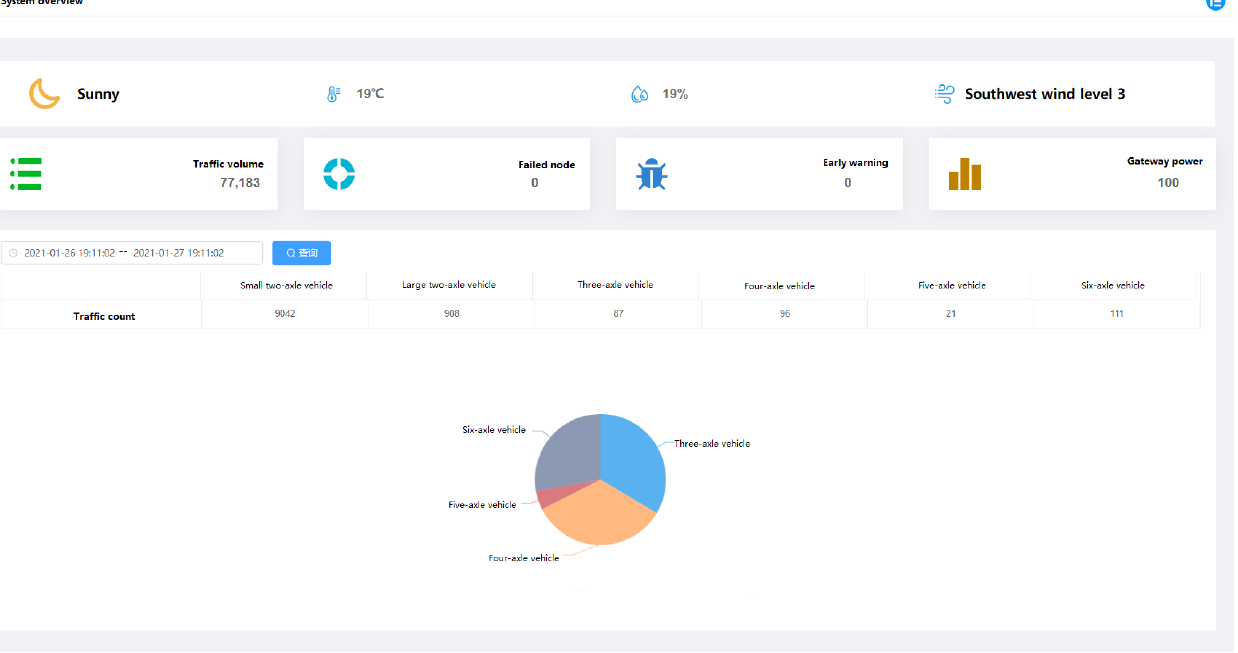
Figure 12. Website interface.